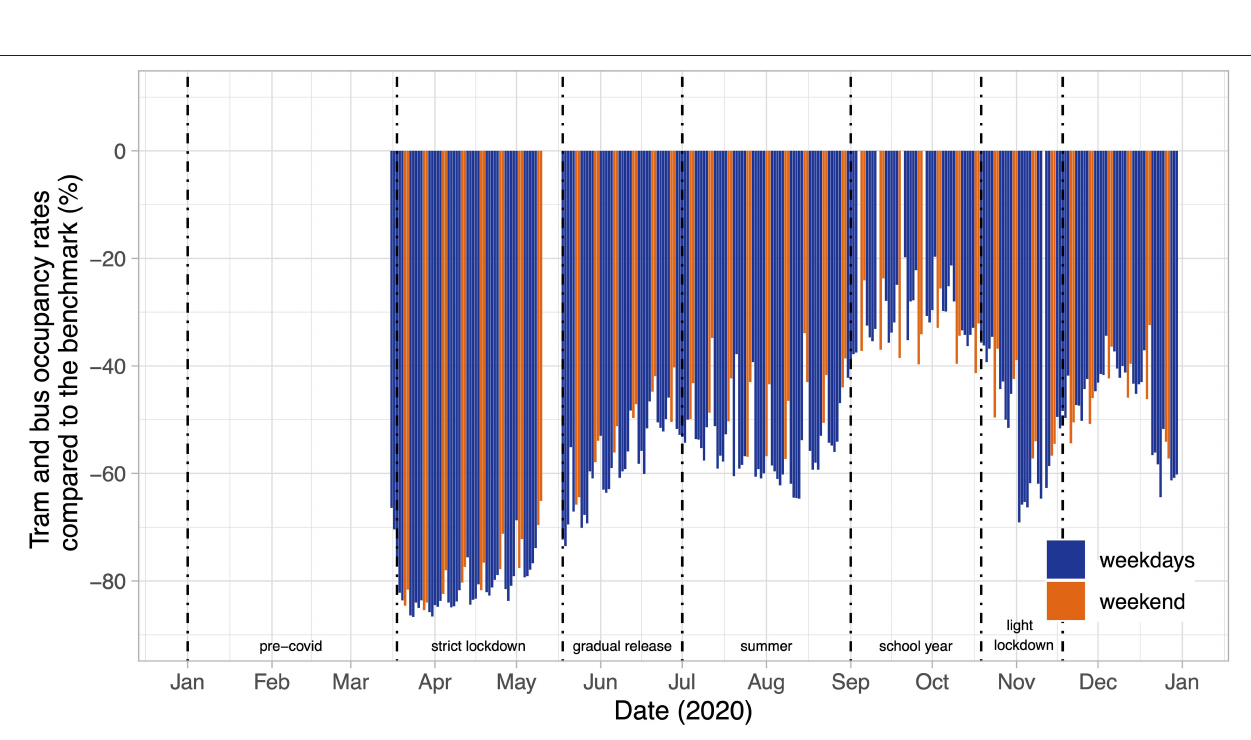
Frontiers in Sustainability |